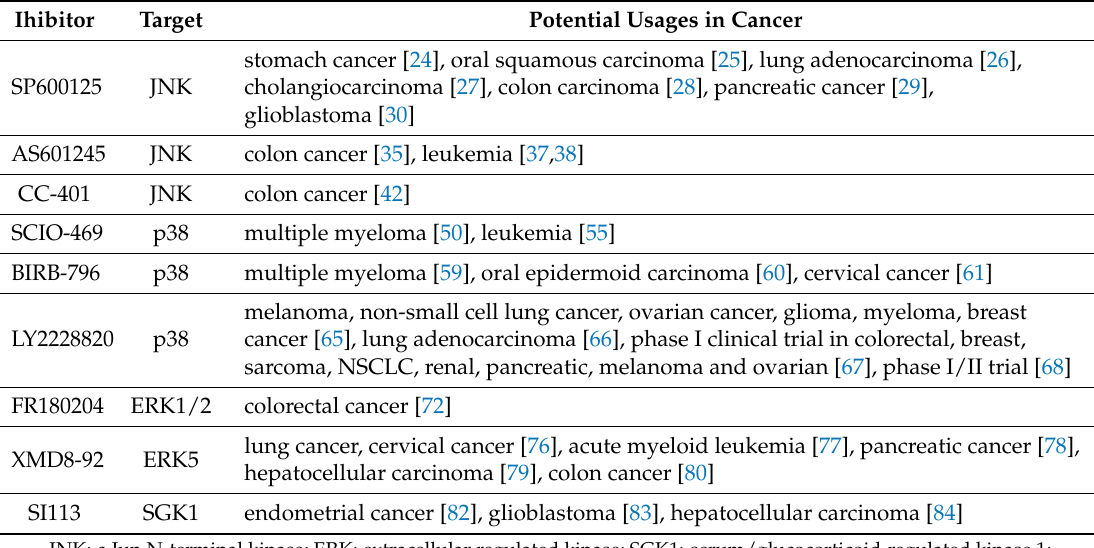
Table 1. The summary of small molecule inhibitors with their potential